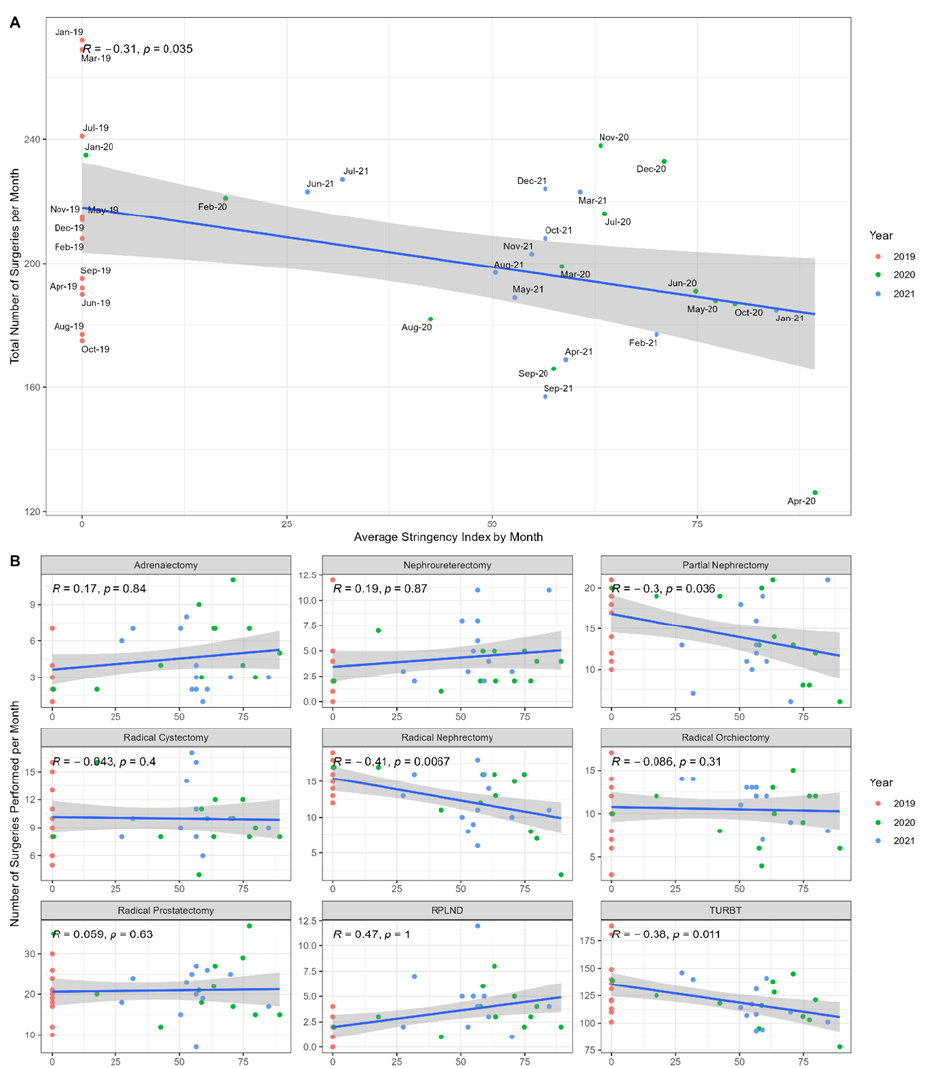
Figure 4. ( A ) Correlation between the total number of urologic surgeries per month and the monthly average Oxford Stringency Index. ( B ) Subgroup analysis per surgery